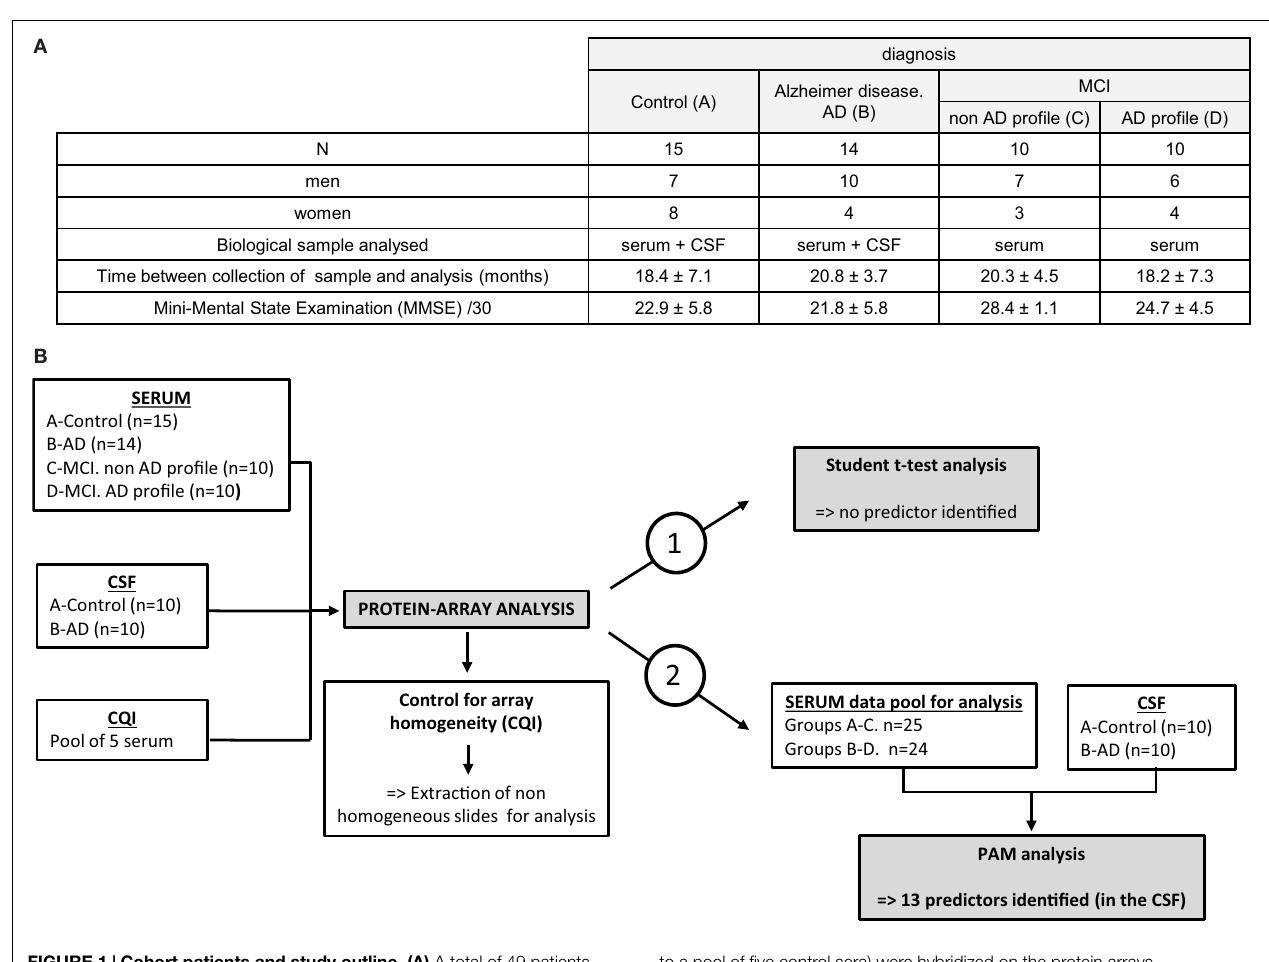
FIGURE 1 | Cohort patients and study outline . (A) A total of 49 patients were included in the preliminary study for protein-arrays analysis: 15 control subjects (A), 14 AD late-stage patients (B) and 20 MCI (mild cognitive impairment): 10 MCI with non-AD profile (C) and 10 MCI presenting AD profile (D). Serum was analyzed for every patient included; CSF was analyzed for 20 of them (10 patients from groups A and B). Time between collection of samples (serum and CSF) and their analysis is indicated (in months): results are mean (cid:6) SD. Mini-mental state examination (MMSE) is indicated (MMSE/30) as mean (cid:6) SD. (B) Sera, CSF, and our internal quality control (CQI, corresponding